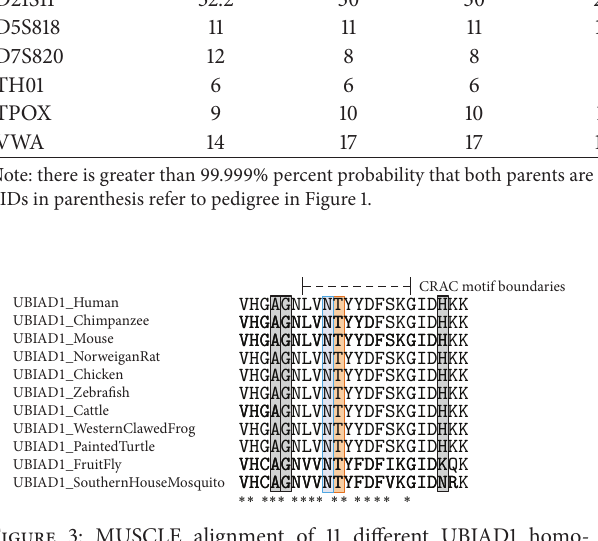
Figure 3: MUSCLE alignment of 11 different UBIAD1 homo- logues showing binding motifs. Shown are excerpts of homologous sequences of 11 different species, corresponding to amino acid residues 93 to 115 in human UBIAD1 protein. The boundaries of the cholesterol recognition/interaction amino acid consensus (CRAC) sequence are denoted by the dashed lines. The Asn102 and Thr103 residues are highlighted in blue and orange, respectively. All other reported mutations in this region associated with SCD are highlighted in gray. An asterisk ( ∗ ) indicates residues that are fully conserved across all 11 aligned